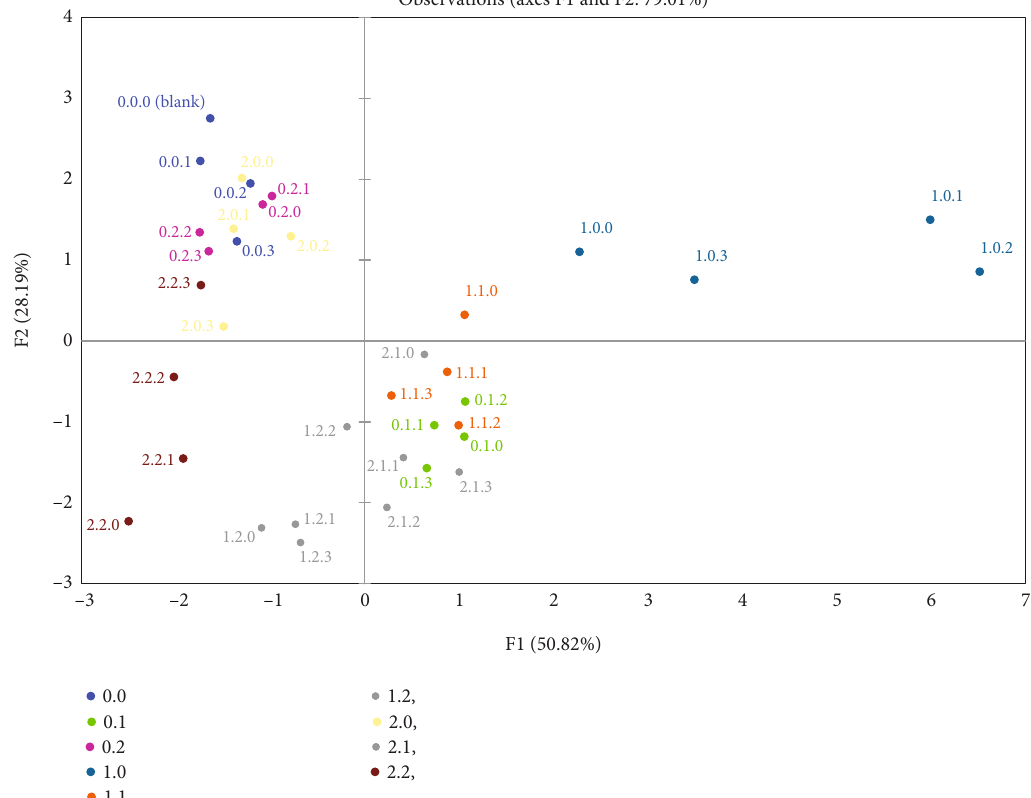
Figure 6: The projection of samples onto the space spanned by the fi rst two principal components (explaining more than 79.01% of the original